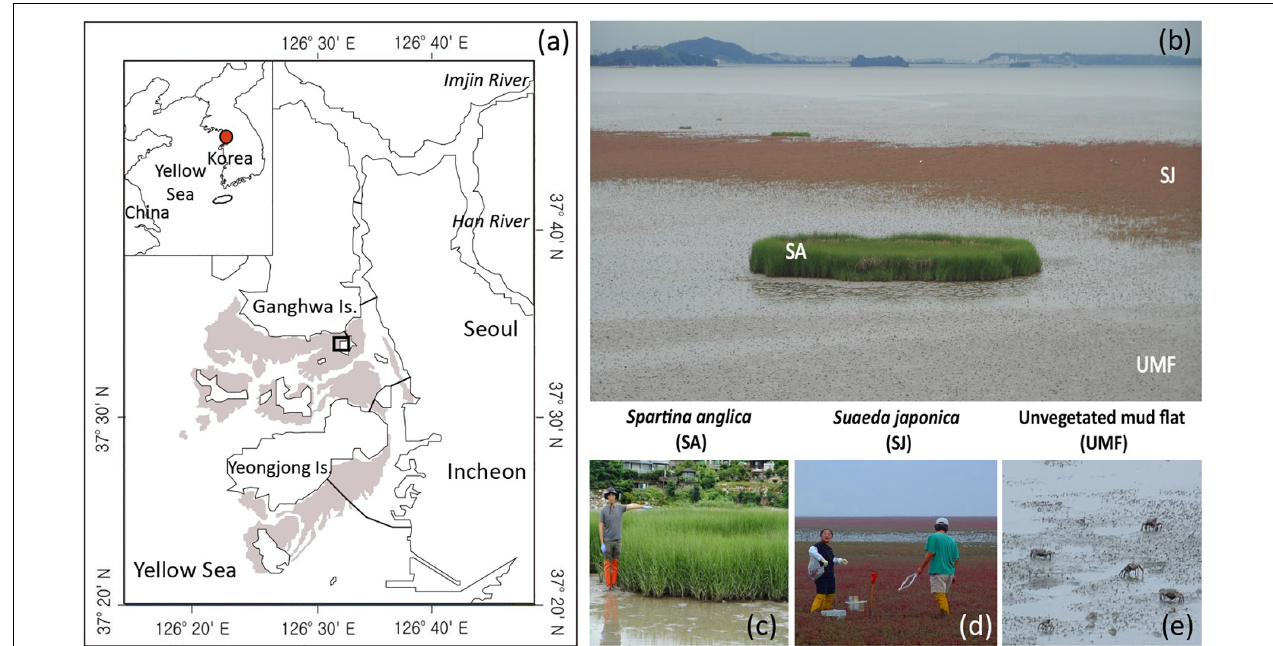
FIGURE 1 | A map showing sampling sites inhabited by Spartina anglica (SA) and Suaeda japonica (SJ) and the unvegetated mud flat (UMF) of the Ganghwa intertidal wetland (a,b) . Shaded area and the lines between land and island in (a) denote the intertidal wetlands and bridges, respectively. Note that the height of the SA shoot reaches 170 cm (c) whereas that of the SJ reaches approximately 30 cm (d) . Crabs ( Macrophthalmus japonicus ) are the dominant macrofauna in the UMF site (e)